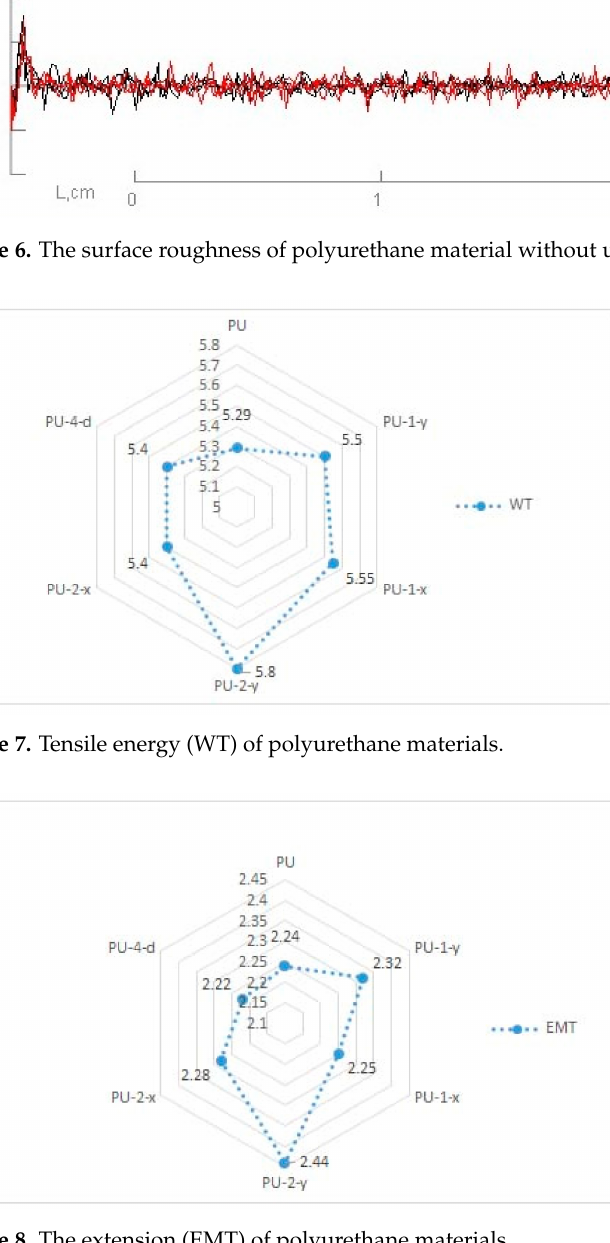
Figure 8. The extension (EMT) of polyurethane